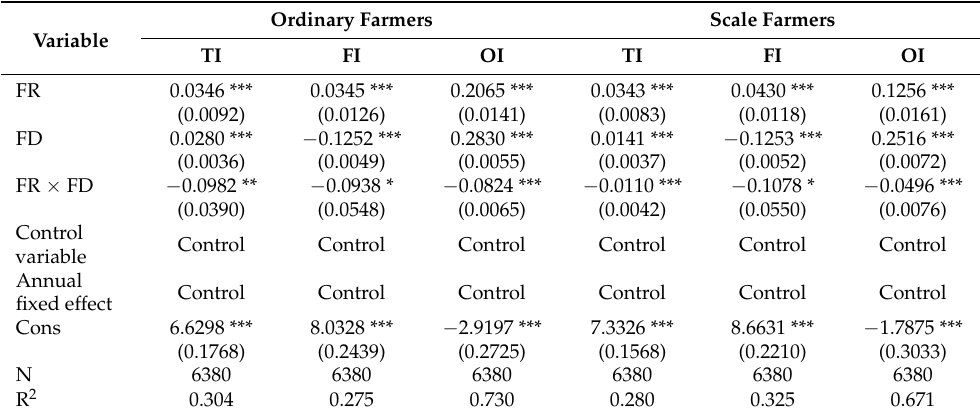
Table A5. Impact of collective forestland tenure reform on household’s income under different forest land management scale.